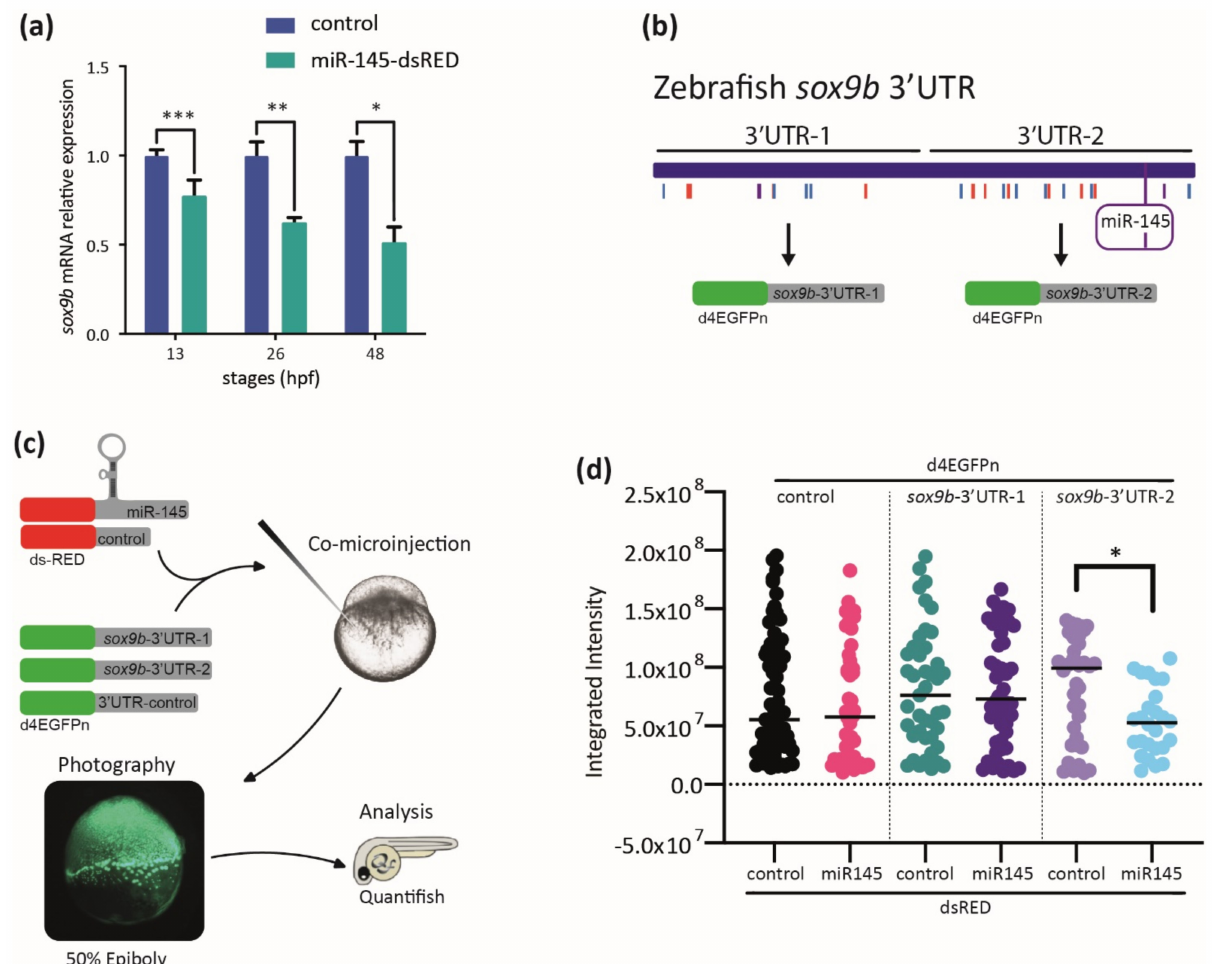
Figure 8. MiR-145 controls sox9b expression. ( a ) Relative levels of sox9b mRNA in miR-145-dsRED microinjected and control embryos; bars represent values measured at each developmental stage normalized to the amount of the corresponding mRNA measured in controls at 13, 26, 48, and 72 hpf ( ± S.E.M., n = 4). Two-tailed Student’s t -test, * p = 0.03; ** p = 0.012; *** p = 0.002. ( b ) Schematic representation of the cloning of sox9b 3 (cid:48) UTR fragments 1 and 2, with putative miRNA sites marked with colored lines and miR-145 enclosed in a purple box. ( c ) Schematic representation of the experimental strategy followed for the study of dGFP expression. ( d ) Quantification of dGFP in embryos co-microinjected with miR-145-dsRED or control-dsRED and different 3 (cid:48) UTRs ( n = 4). Two-tailed Student’s t -test, * p =